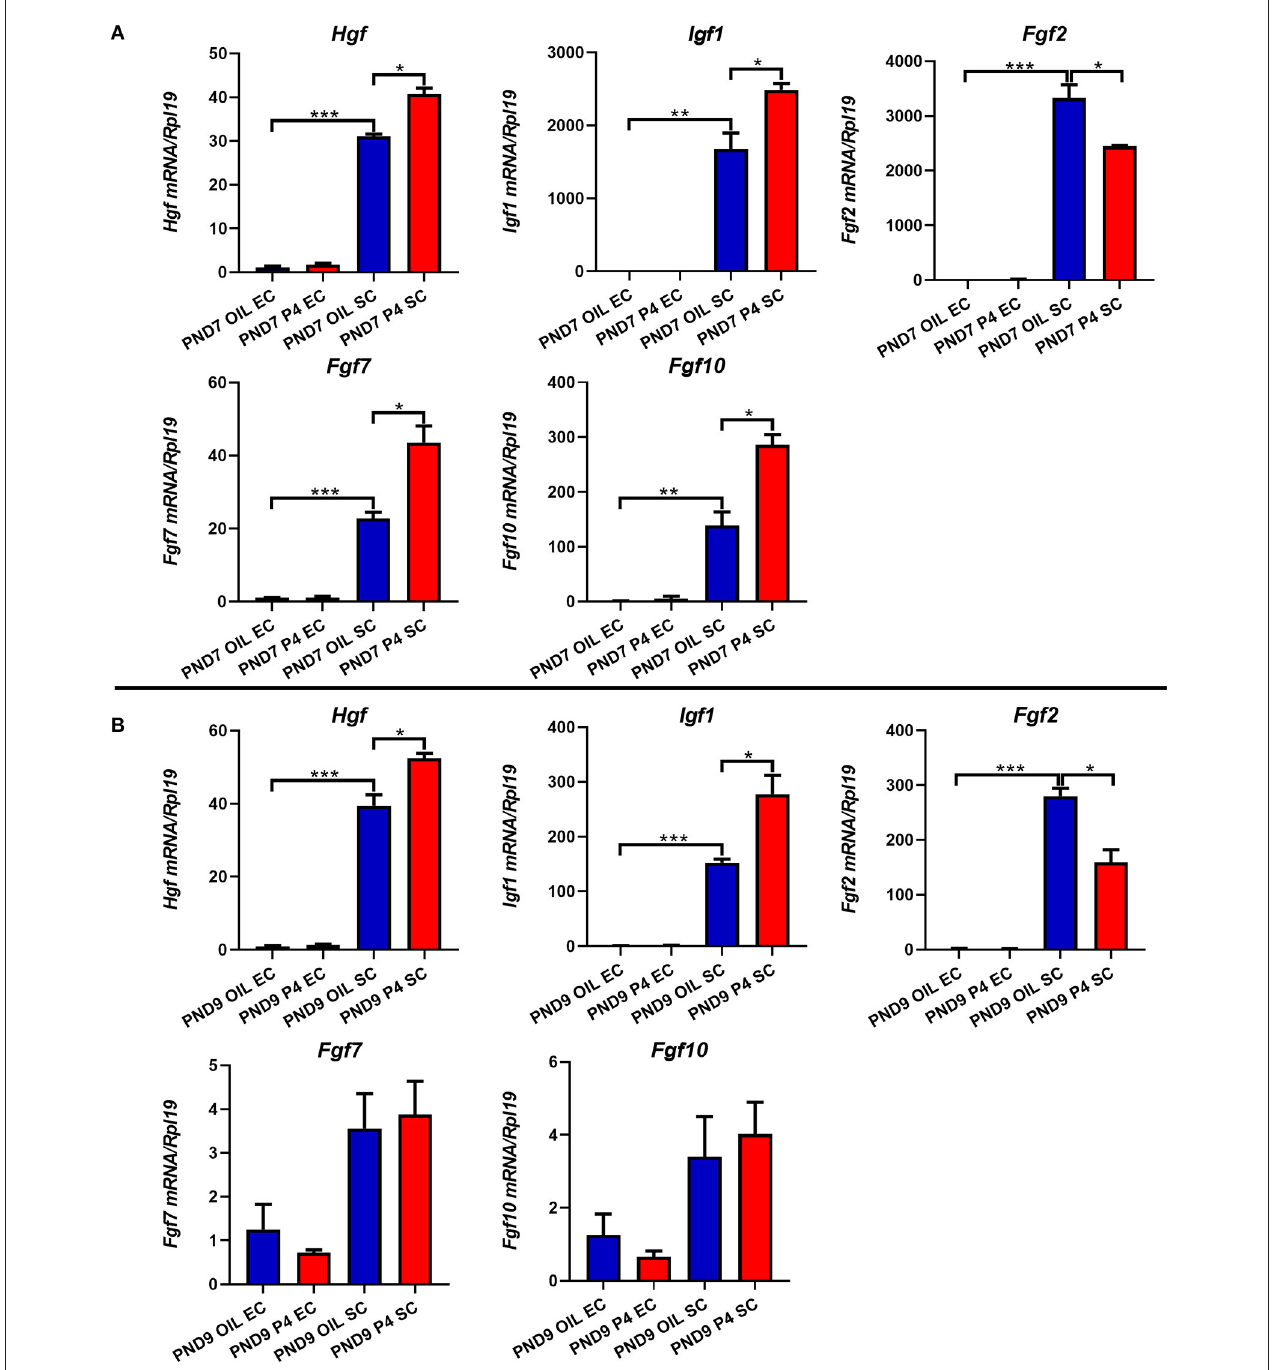
FIGURE 9 | Effects of endometrial gland dysgenesis on the expression of Hgf , Fgf2 , Fgf7 , Fgf10 , and Igf1 . The expressions of Hgf , Fgf2 , Fgf7 , Fgf10 , and Igf1 in endometrial epithelium or stroma after treated with P4 or Sesame oil on PND7 (A) and PND9 (B) . Results are means ± SEM ( n = 5). Bars with different superscripts are significantly different ( P <